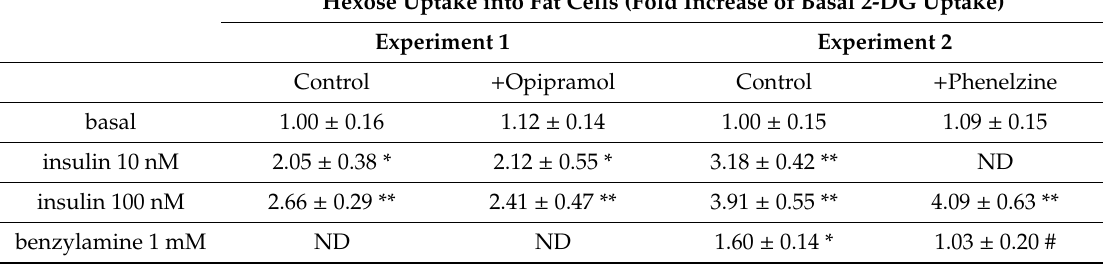
Table 1. Glucose transport in human